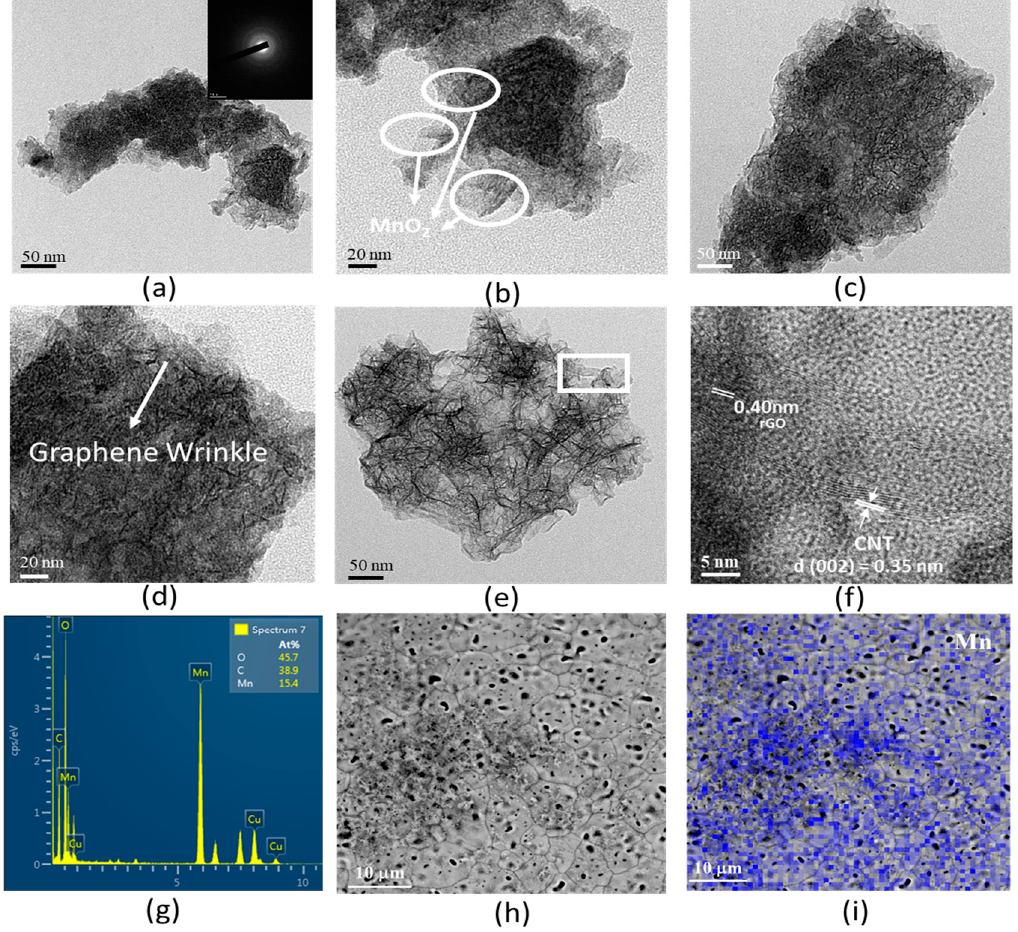
Figure 3. The TEM analysis for the as-obtained MnO 2 material ( a , b ), MnO 2 / rGO ( c , d ) and MnO 2 / rGO-MWCNT material ( e , f ), EDS of MnO 2 / rGO-MWCNT / NF material ( g ), SEM and mapping of MnO 2 / rGO-MWCNT / NF material ( h , i ), respectively.